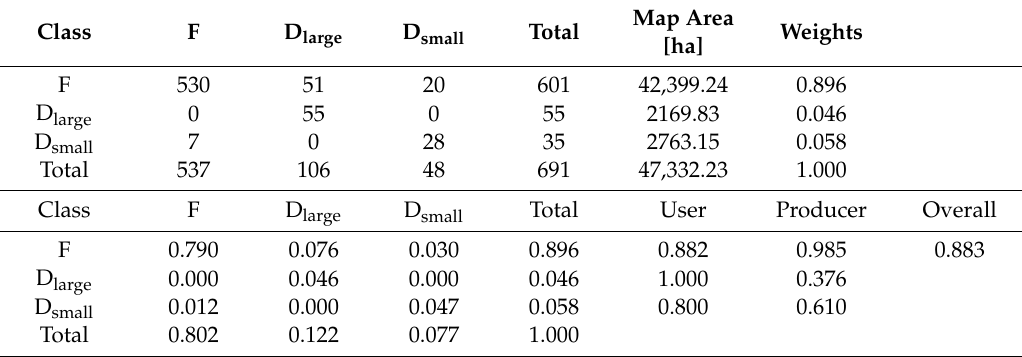
Table A12. “S1 Only” disturbance method validation Gabon (only forest area).